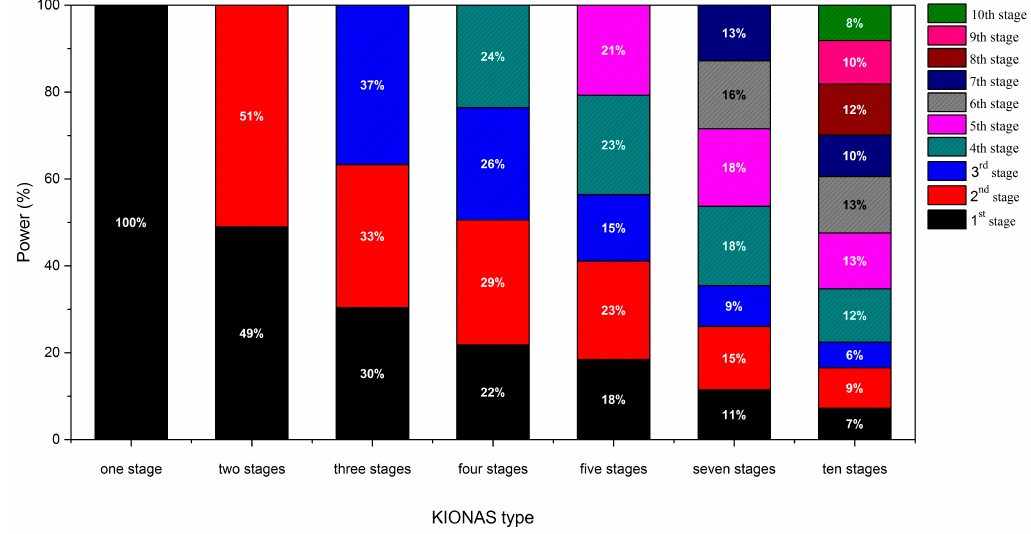
Figure 9. Each stage’s contribution in the total power of each KIONAS type.